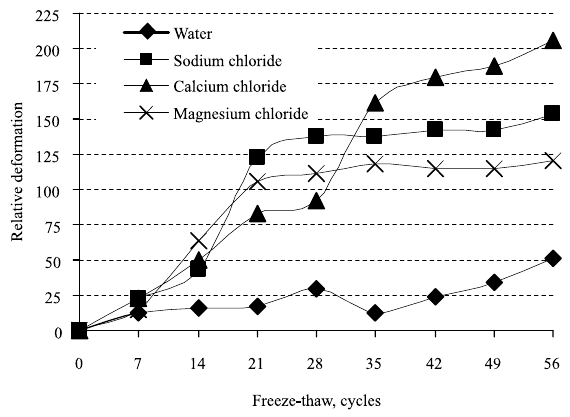
Fig. 5. Kinetics of deformations in specimens made of Portland cement after 56 freeze-thaw cycles in different saline solutions